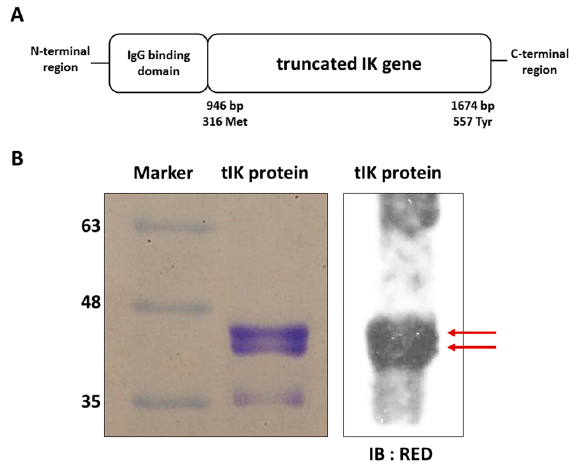
Figure 1. Exogenous truncated IK (tIK) protein is expressed in an insect cell culture system. ( A ) Diagram of the immunoglobulin G (IgG) binding domain-tagged tIK protein with nucleotide and amino acid sequence numbers was generated according to reference [6]; ( B ) Purified tIK protein was stained by Coomassie blue after SDS-PAGE (left). The size of the tIK protein was predicted to be approximately 40 kDa. tIK protein was also detected by Western blotting (right) using RED-specific primary antibody, which recognizes a unique amino acid sequence located in tIK. The red arrows indicate the expected tIK protein.